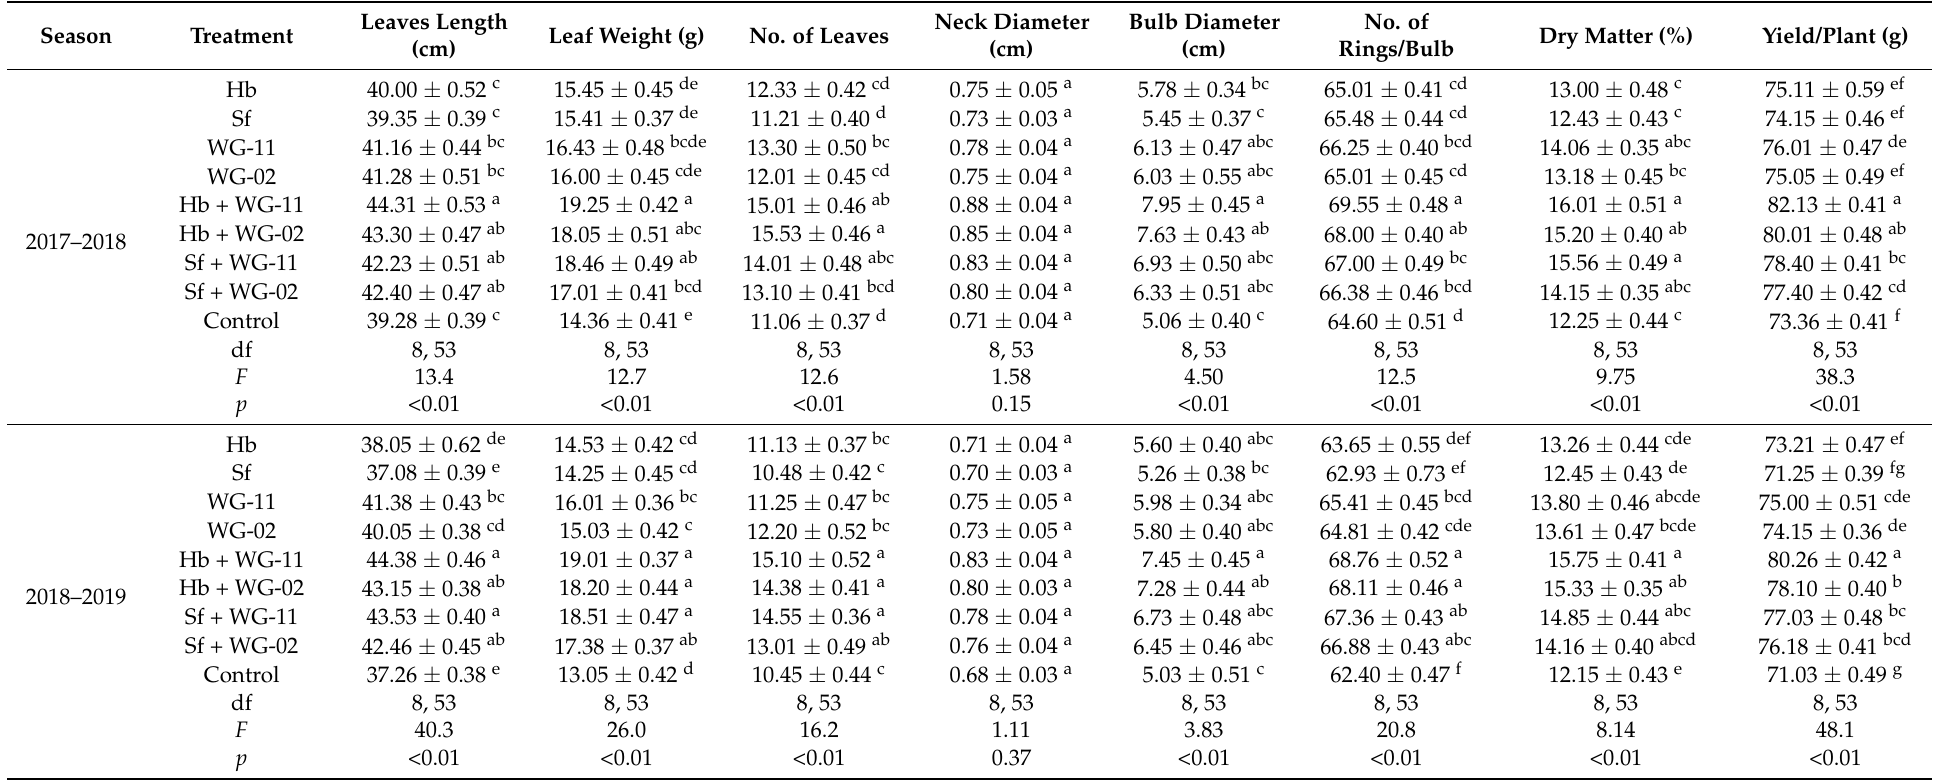
Table 6. Effect of different treatments Hb = Heterorhabditis bacteriophora, Sf = Steinernema feltiae, WG-11 = Beauveria bassiana (WG-11), WG-02 = Metarhizium anisopliae (WG-02), Hb + WG-11 = H. bacteriophora + B. bassiana, Hb + WG-02 = H. bacteriophora + M. anisopliae, Sf + WG-11 = S. feltiae + B. bassiana, Sf + WG-02 = S. feltiae + M. anisopliae, control = water